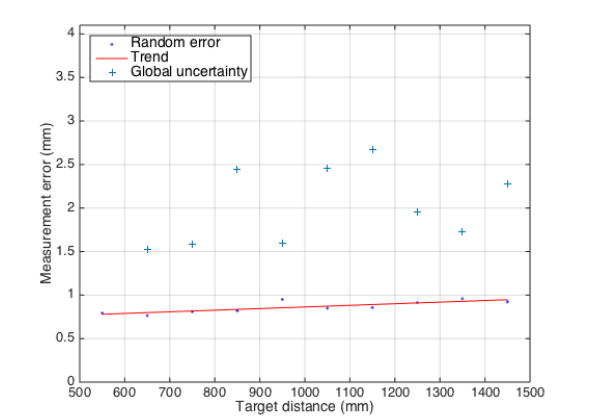
Figure 9. Microsoft Kinect2 global uncertainty, random error and linear fitting on the random error ( ρ =0.8127).